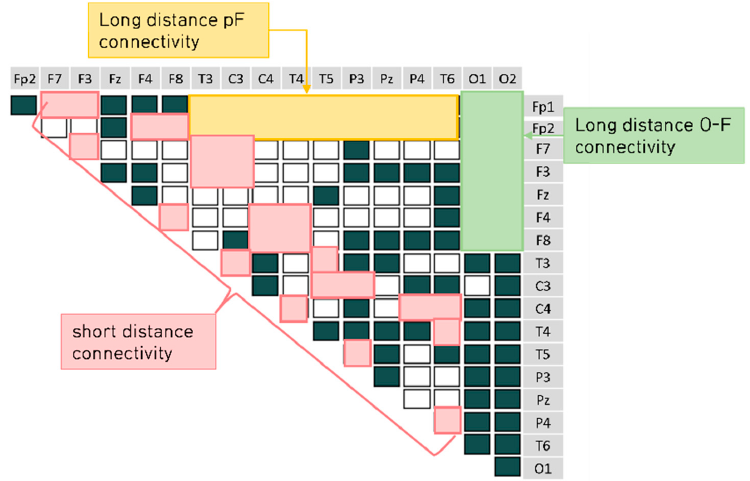
Figure 10. The brain connectivity map in the unpleasant-aroused condition.